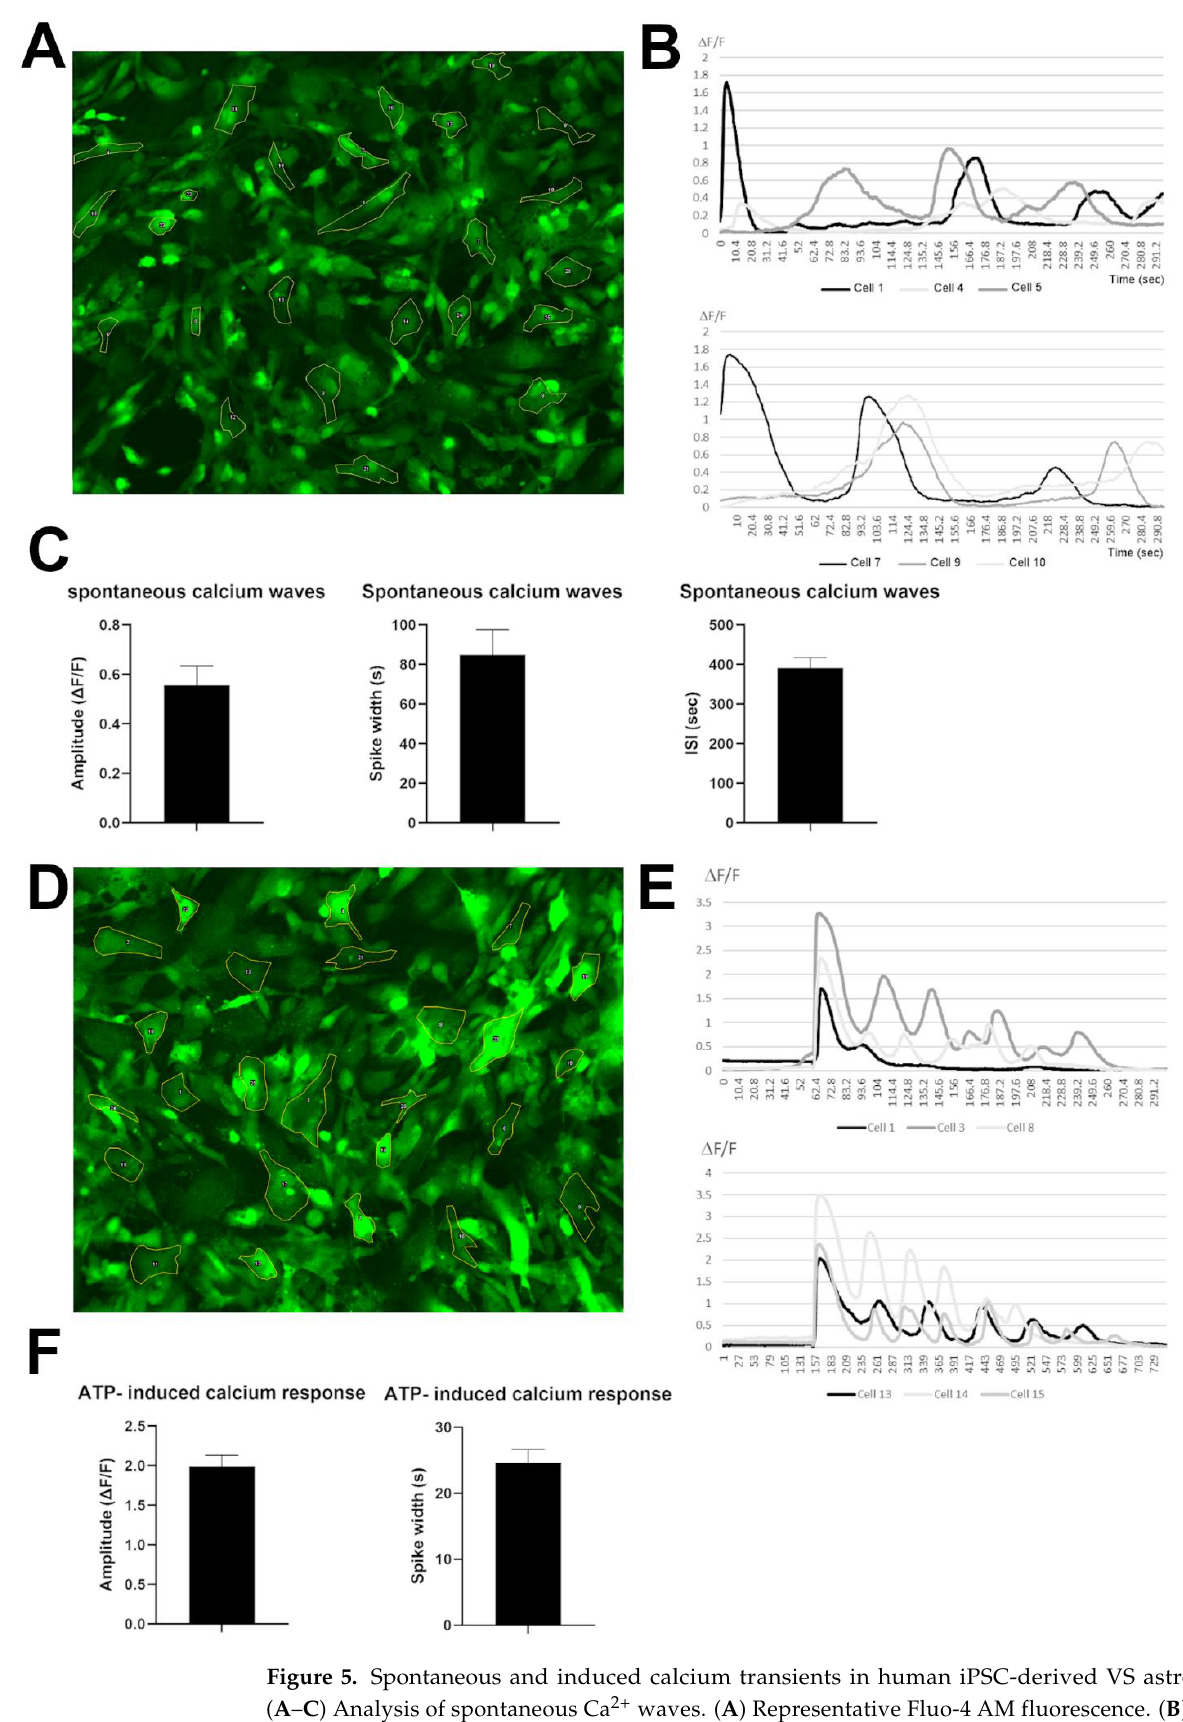
Figure 5. Spontaneous and induced calcium transients in human iPSC-derived VS Figure 5 . Spontaneous and induced calcium transients in human iPSC-derived VS astrocytes. ( A – C ) Analysis of spontaneous Ca 2+ waves. ( A ) Representative Fluo-4 AM fluorescence. ( B ) ∆ F/F signals over time for 6 selected cells. ( C ) Quantification of spontaneous transients ’ characteristics including